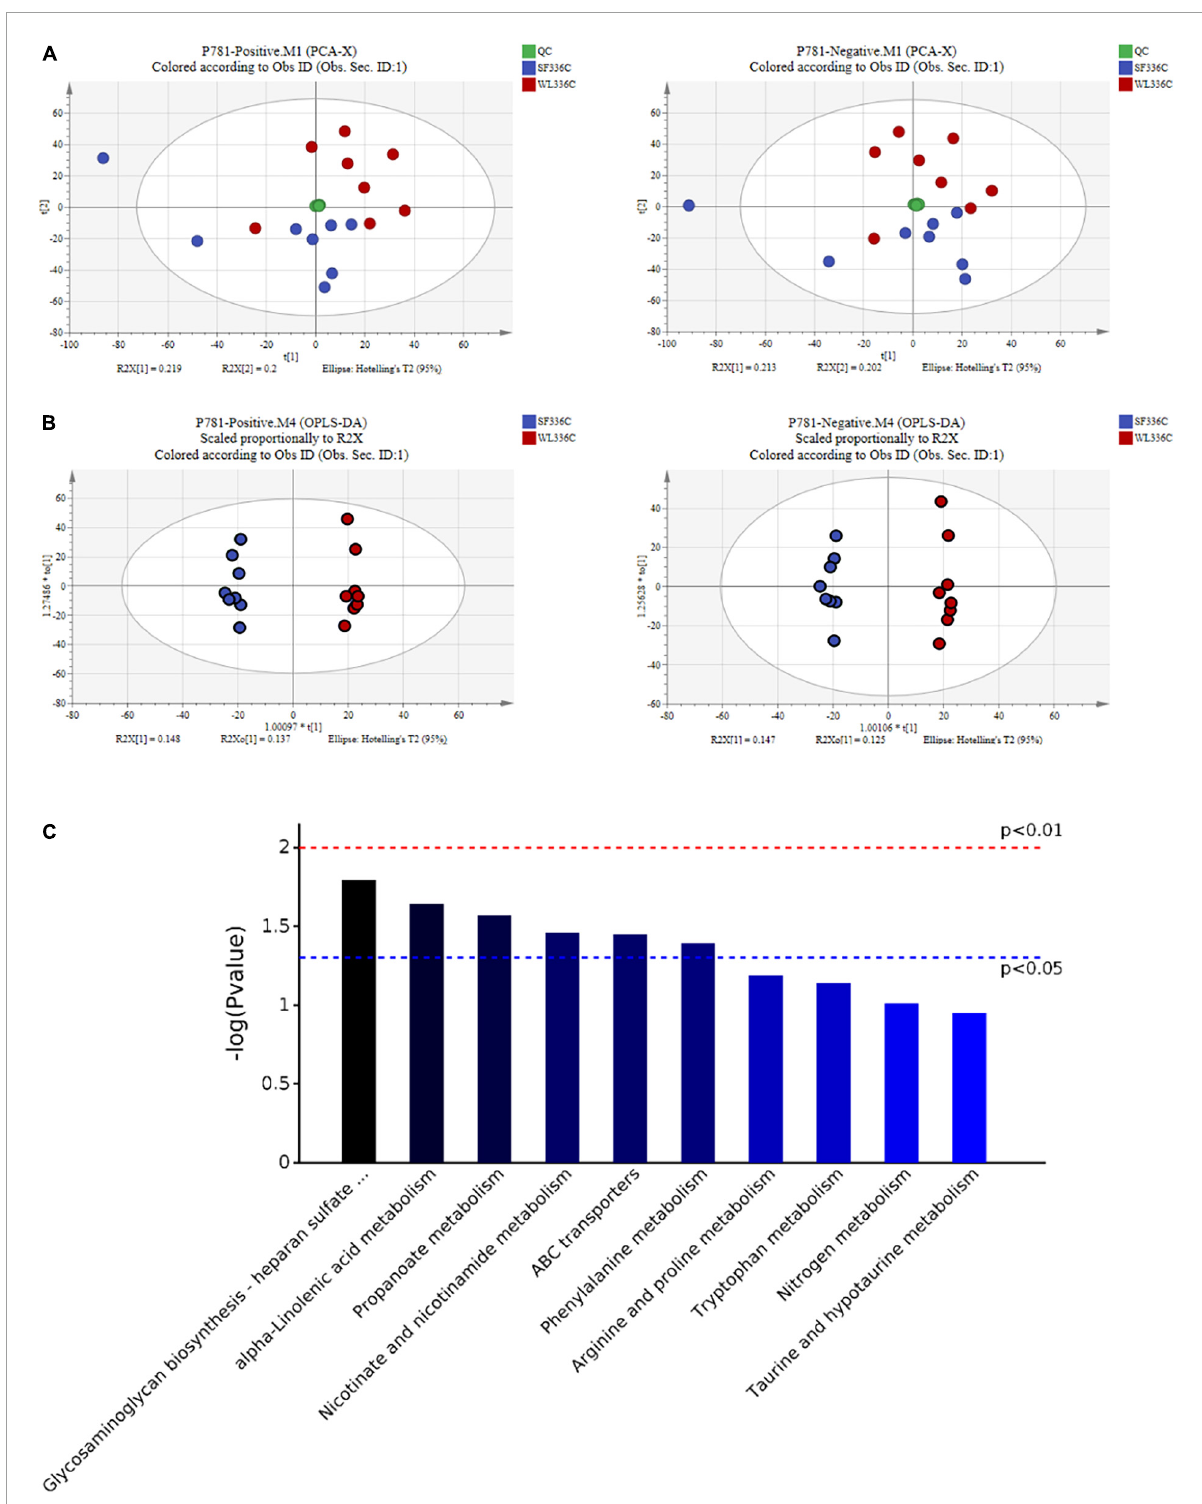
FIGURE3 The pattern discriminant and composition description of cecal metabolites in WL and SF. (A) PCA pattern recognition in positive ion (ESI +) and negative ion (ESI-) mode. (B) Discrimination of OPLS-DA mode in positive ion (ESI +) and negative ion (ESI-) mode. (C) The Bar chart of differential metabolic